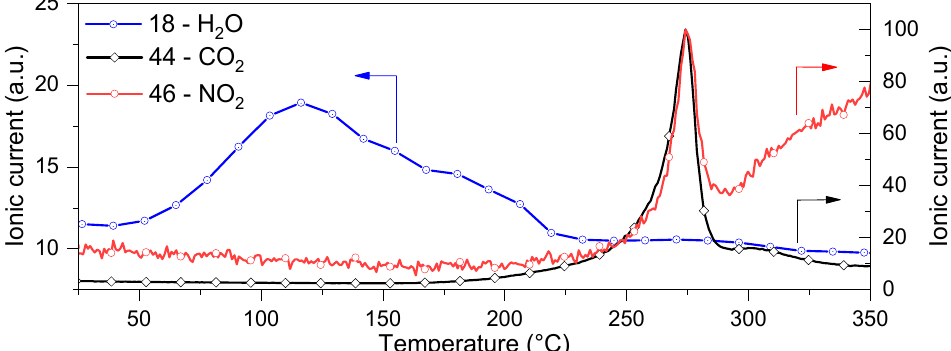
Figure 4. TG profile of CaHS under inert atmosphere (120 mL/min N 2 ) while heating the CaHS from r.T. to 200 °C.